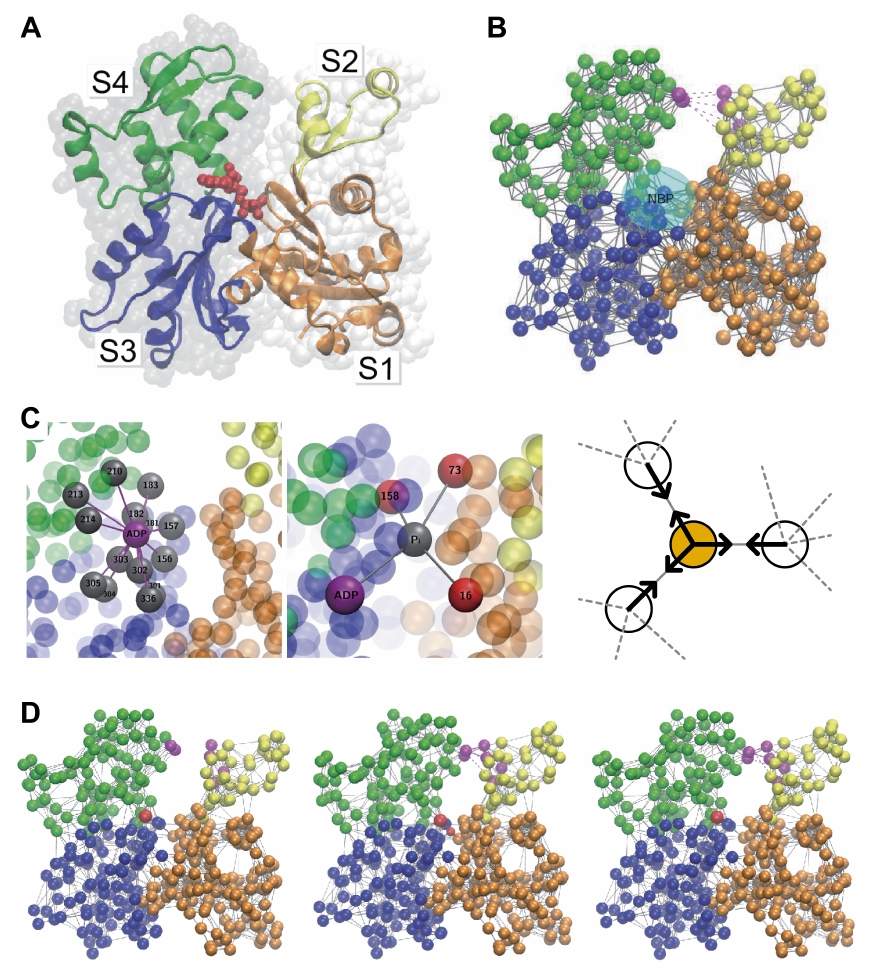
Figure 3. Ligand-induced conformational changes simulated by ENMs. ( A ) structure of G-actin and ( B ) its ENM representation; ( C ) In the nucleotide binding pocket (NBP), two additional particles (ADP and P i ) were introduced to mimic ligand binding. The natural lengths of springs connected to P i (solid lines in the schematic) was set shorter than the distances in the reference structure, so that they introduce attractive forces (arrows), mimicking the shrinkage of the NBP upon ATP binding; ( D ) The motion introduced by the ligand, together with additional interactions (breakable links shown in purple lines), suggested ATP-induced transition to the closed conformation ( left to center ), which may explain the acceleration of actin polymerization by ATP. A metastable closed state after ATP hydrolysis and P i release ( right ) was also observed. Reproduced from [71] with